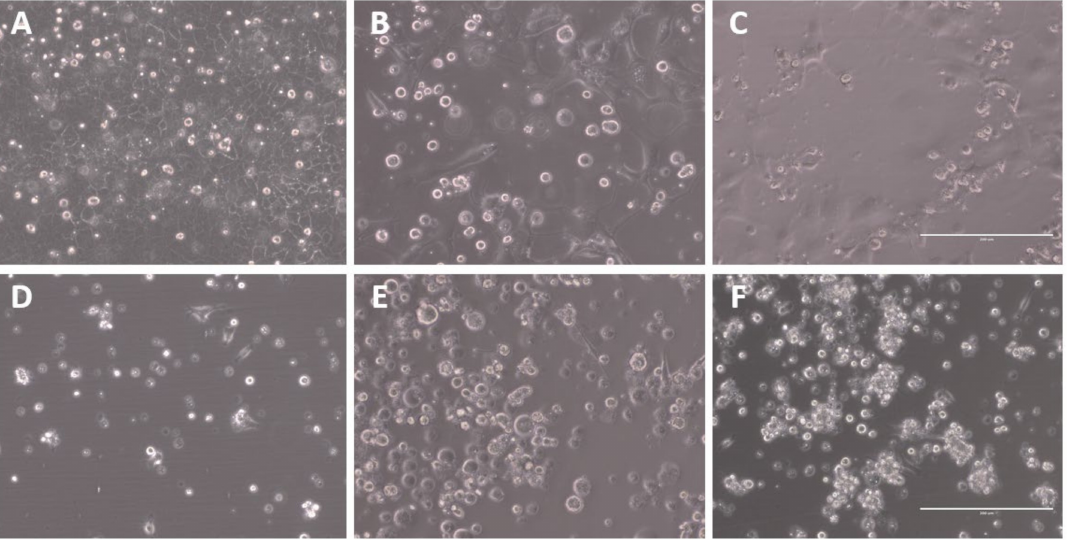
Figure 1. Representative images of viral CPE of A/Singapore/G2-31.1/2014 infection of MDCK- SIAT1 and CEF cells at 3 days post-infection (dpi). Microscopic images were captured using the EVOS XL microscope at 20 × magnification. The scale bar (bottom right) represents 200 µ m. ( A ) Uninfected MDCK-SIAT1 and infected MDCK-SIAT1 cells at ( B ) P1 and ( C ) P5. ( D ) Uninfected CEFs and infected CEFs at ( E ) P1 and ( F )